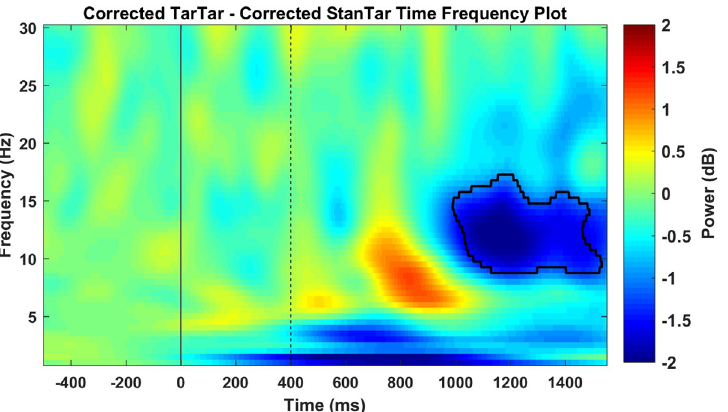
Fig 8. Time-frequency map of the power difference between corrected target-target and corrected standard target conditions. The demarcated area corresponds to time-frequency difference points with a p-value < 0.01 using permutation-based statistical testing with cluster-based multiple comparison correction. The solid black line indicates the onset of auditory stimuli and the black dashed line shows the onset of visual stimuli. A corrected target-target time- frequency plot was obtained by subtracting each time-frequency point under the target-standard condition from the corresponding point under the target-target condition. Similarly, the corrected standard-target time-frequency map was acquired by subtracting the standard-standard condition from the standard-target time-frequency map. Therefore, the corrected analysis only compares the pure visual target-elicited alpha event-related desynchronization between the two